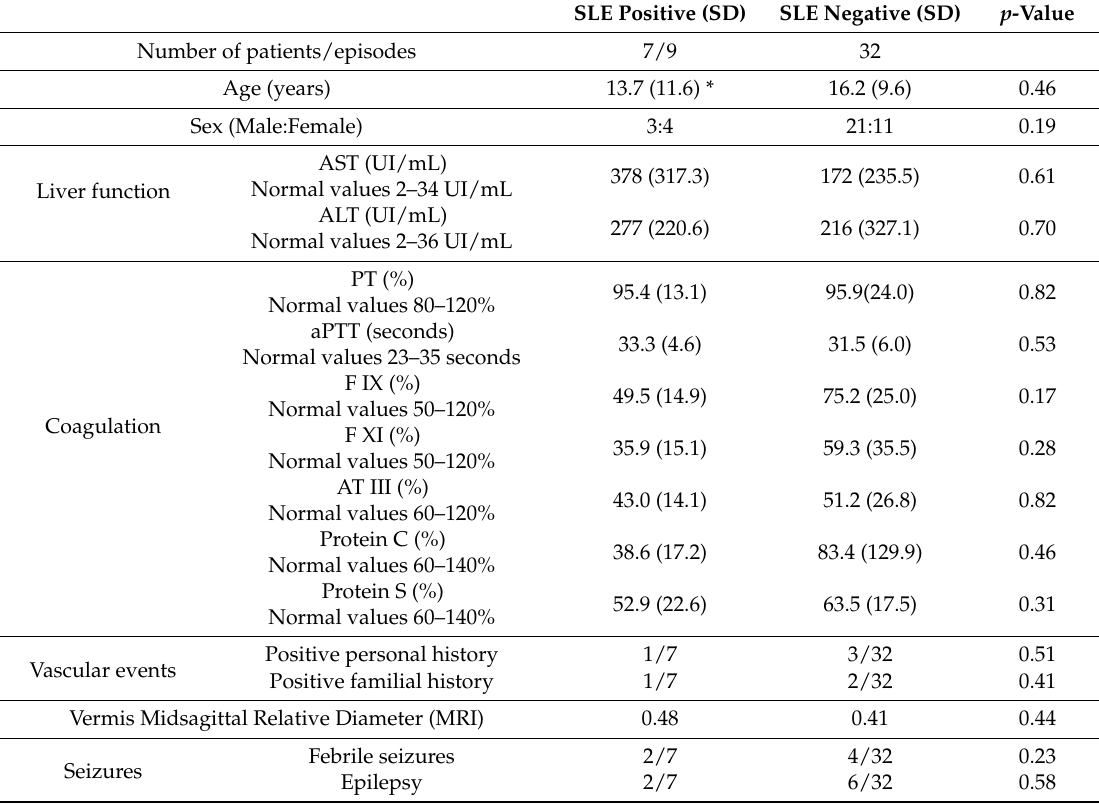
Table 2. Comparison of clinical and epidemiological data between PMM2-CDG patients with and without